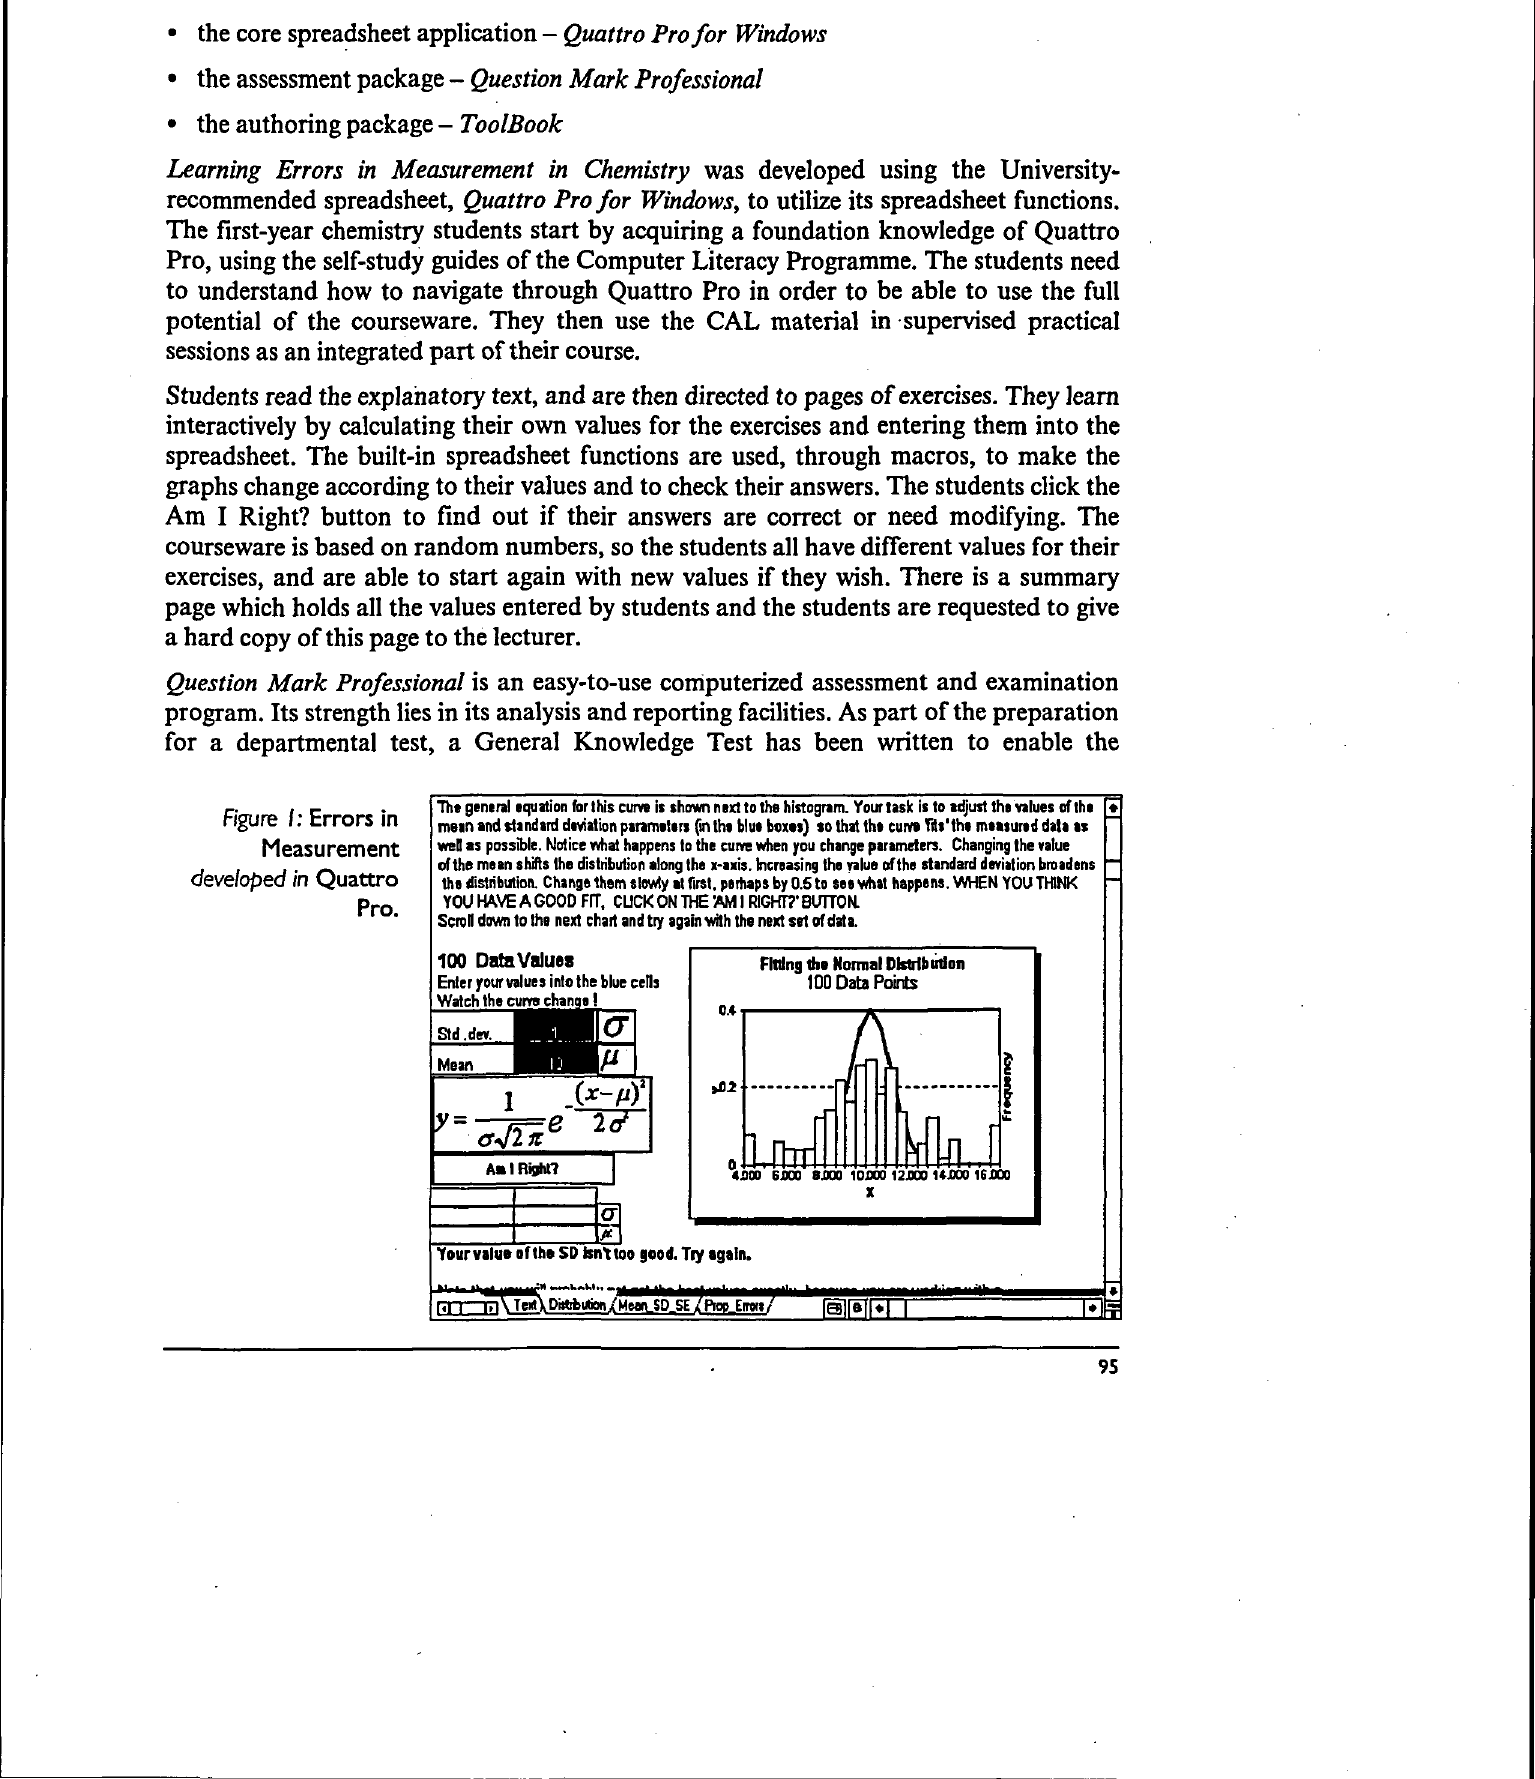
Figure f: Errors ¡n Measurement developed in